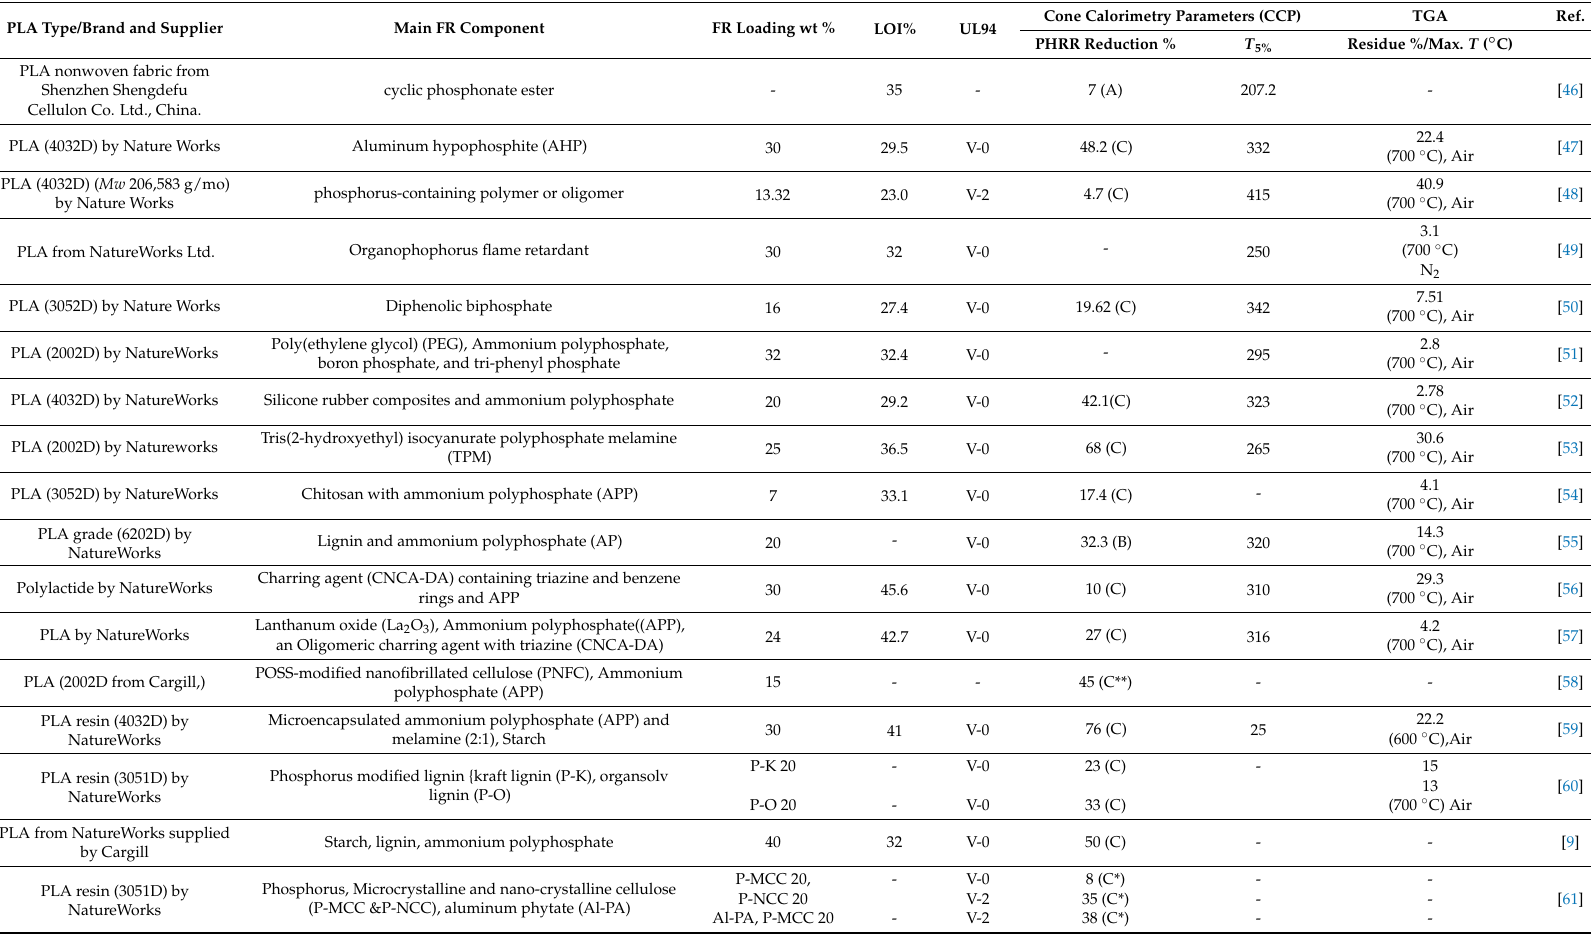
Table 1. Phosphorus-based flame retardants and their combinations for